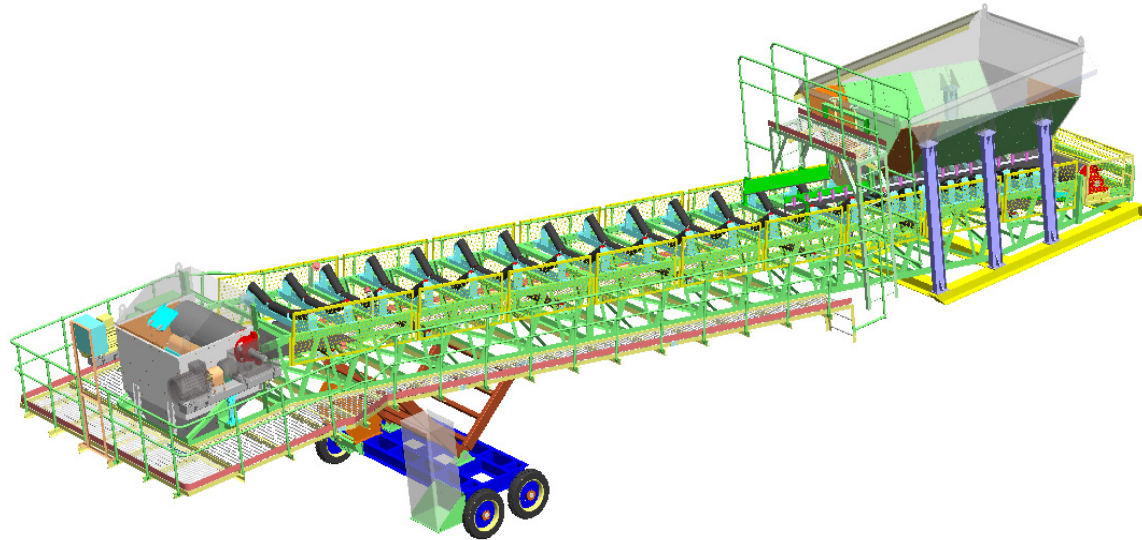
Figure 1. Three-dimensional model of coal gangue conveyor.